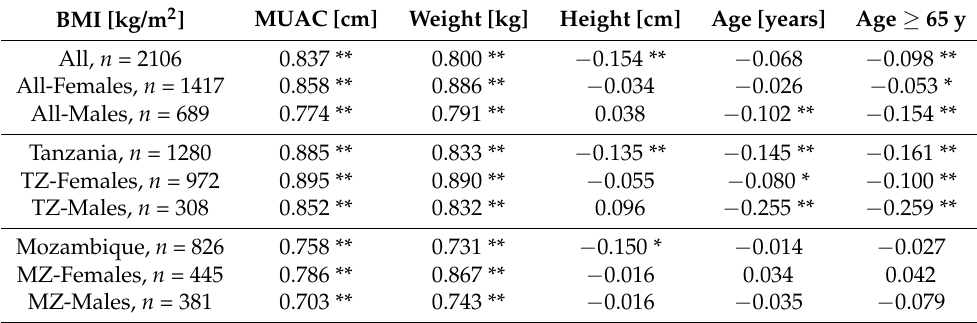
Table 2. Correlation of BMI with MUAC, weight, height, age, and age ≥ 65 among all farmers, and clustered by sex and country.